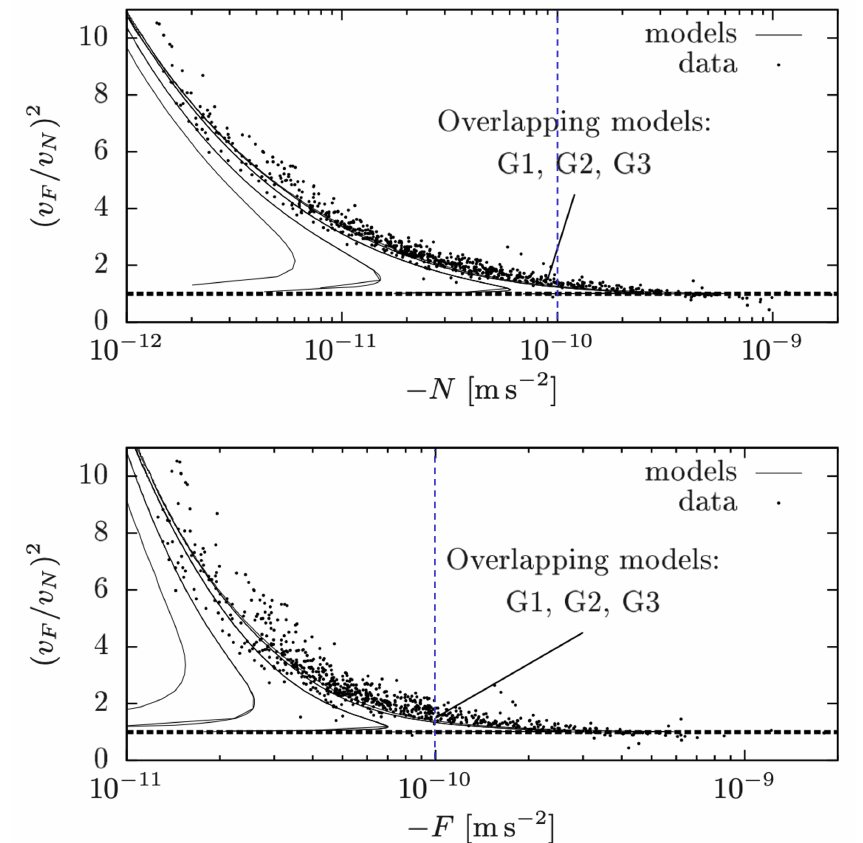
Figure 6. The MDAR built in RG as the squared ratio between the SRG and the Newtonian speeds, v F and v N , respectively, as a function of the Newtonian ( top panel ) and the SRG ( bottom panel ) accelerations, − N and − F , respectively, for the same set of models represented as open circles and squares in Figure 5 (black solid lines) and for a set of point masses having m = 10 x M (cid:12) , with x = { 7,8,9,10,11,12 } (black dotted lines). The solid and dotted lines appear almost indistinguishable in the ( − N , ( v F / v N ) 2 ) and ( − F , ( v F / v N ) 2 ) planes. The gas-rich galaxies models appear in the leftmost part of the plots, indicating that they are always in the “mass discrepancy regime”. The curves are plotted together with observational measurements from [21,23] (black dots), showing that they properly reproduce the data. The black dashed line ( v F / v N ) 2 = 1, showing the no mass discrepancy case, and the blue dashed lines − N = 10 − 10 m s − 2 and − F = 10 − 10 m s − 2 are illustrated as a reference in both panels. The figure is re-adapted from Figure 10 in